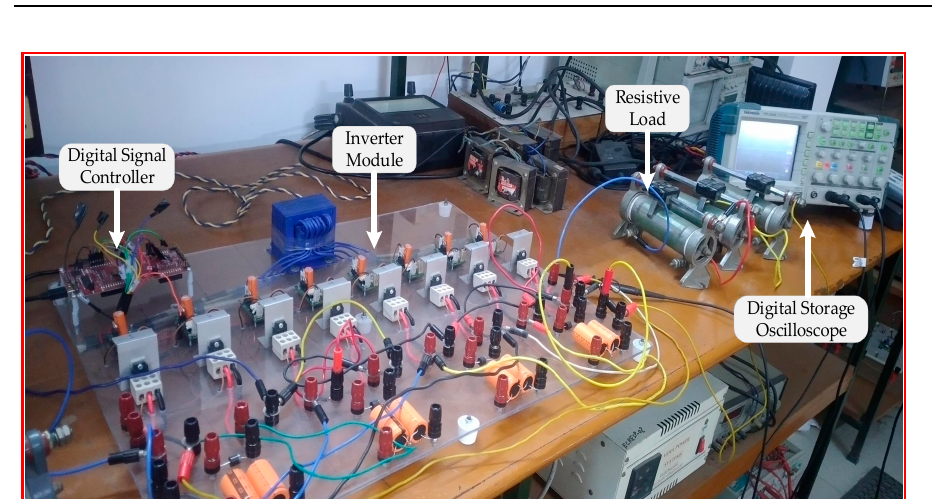
Figure 15. Laboratory experimental setup.